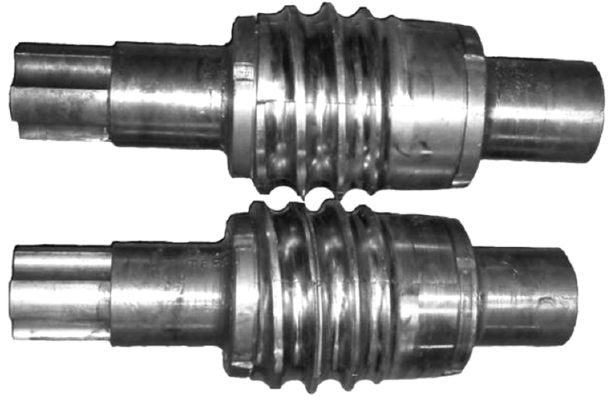
Figure 2. Kit of helical tool segments for forming 33 mm diameter balls.